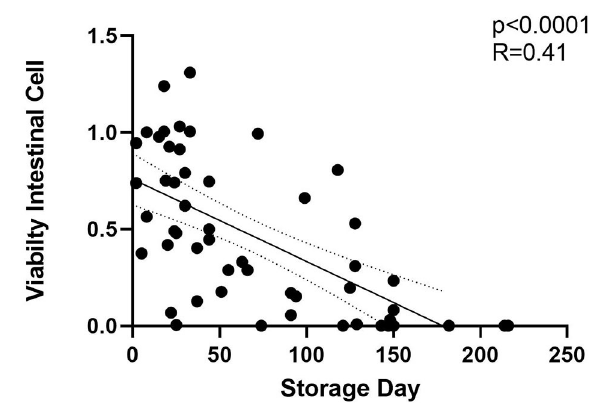
FIGURE 3 | Fetal intestinal cell viability decreases with storage time − 20 ◦ C. Storage time is in days for both HIEC-6 and FHs 74 Int cell lines, normalized. Includes milk viability tests n = 55 from 34 unique milk samples. Significant inverse relationship between cell viability after human milk exposure and time in frozen storage at − 20 ◦ C. LD50 at 60 days is shown in the horizontal dotted line which is the time point at which 50% of samples killed 50% of cells in culture. Curved dotted line represents 95% C.I. of linear regression slope. Simple linear regression by GraphPad Prism 9 ( p < 0.001).